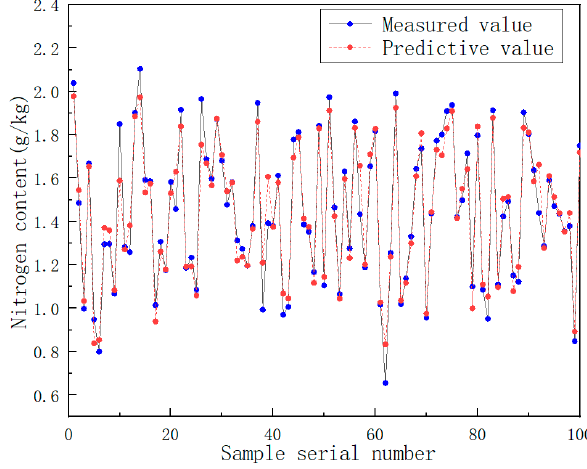
Figure 13. Comparison of predicted and measured nitrogen content in random forest model. Table 5. Nitrogen content tree number and split node number setting and RMSEC statistical graph.